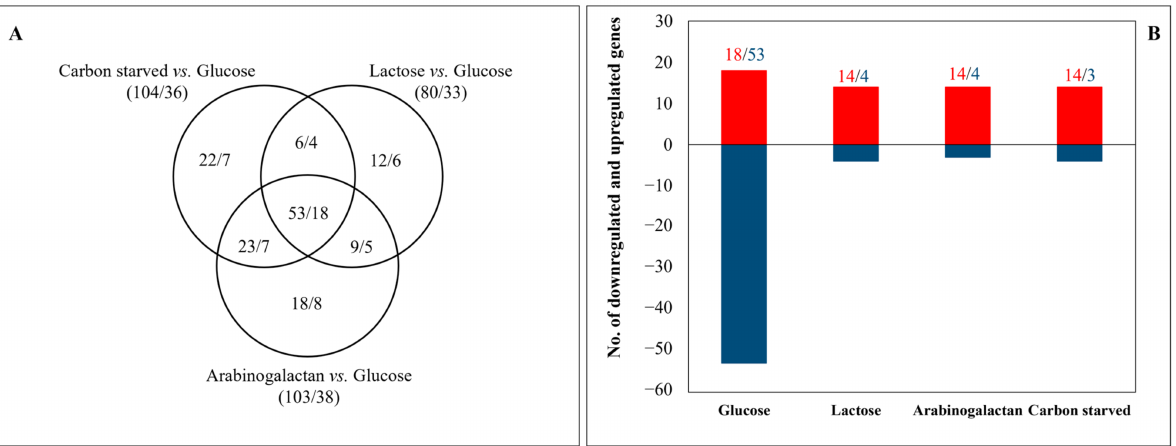
Figure 3. Distribution of carbon-stress-responsive ( A ) and culture-specific ( B ) transcription factor genes among the cultures. Figures represent the number of upregulated/downregulated transcription factor